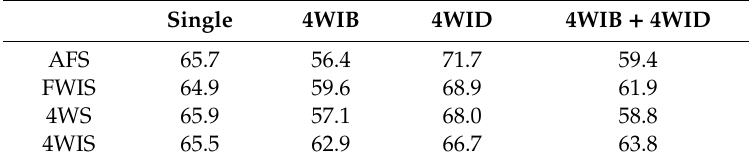
Table 4. Minimum longitudinal velocities for each actuator combination (km / h).